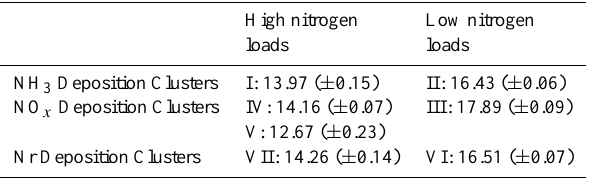
Table 1. Soil C:N values clearly differ by nitrogen deposition cluster. The soil C:N ratios are given as cluster-specific averages ( ± standard error); Roman numerals (I–VII) as in Figs. 1 and 2. Both the three-factor ANOVA with NH 3 , NO x and Nr (NO x and NH 3 ) and the nested ANOVA with NH 3 (Nr) and NO x (Nr) are sig- nificant for their long-term effects on the soil C:N ratios (all share p <0.0001).